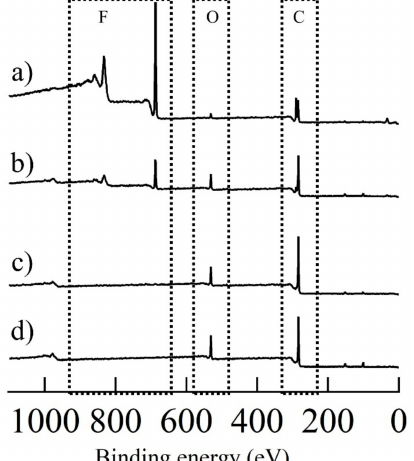
Figure 3. XPS spectra of the ( a ) ETFE film, and the ETFE- g -PSt-CHO (grafting time for: ( b ) 1 h, ( c ) 2 h, and ( d ) 3